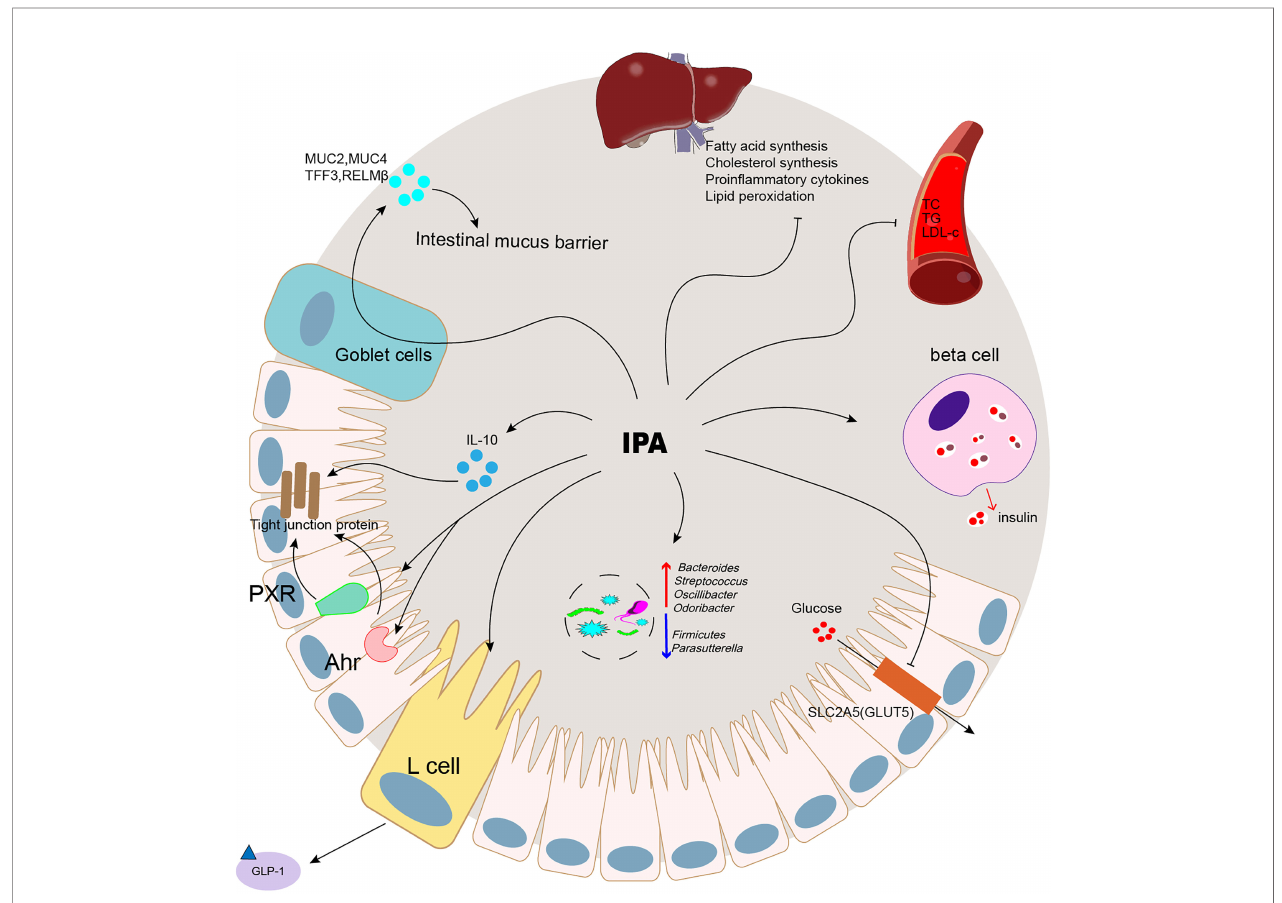
FIGURE 2 | IPA was correlated with the occurrence and development of metabolic